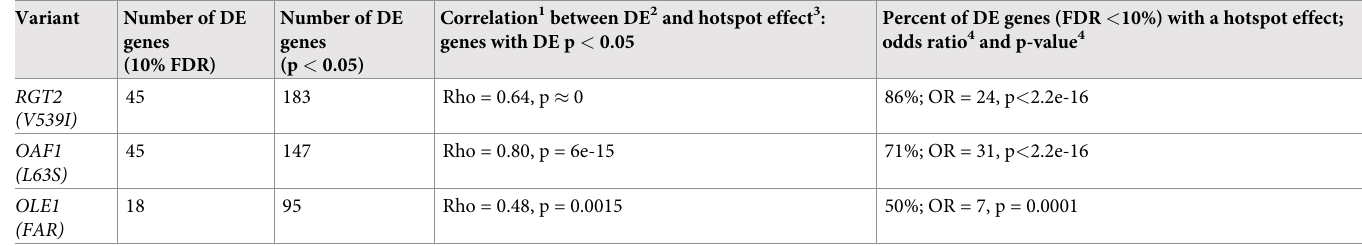
Table 2. RNA Seq